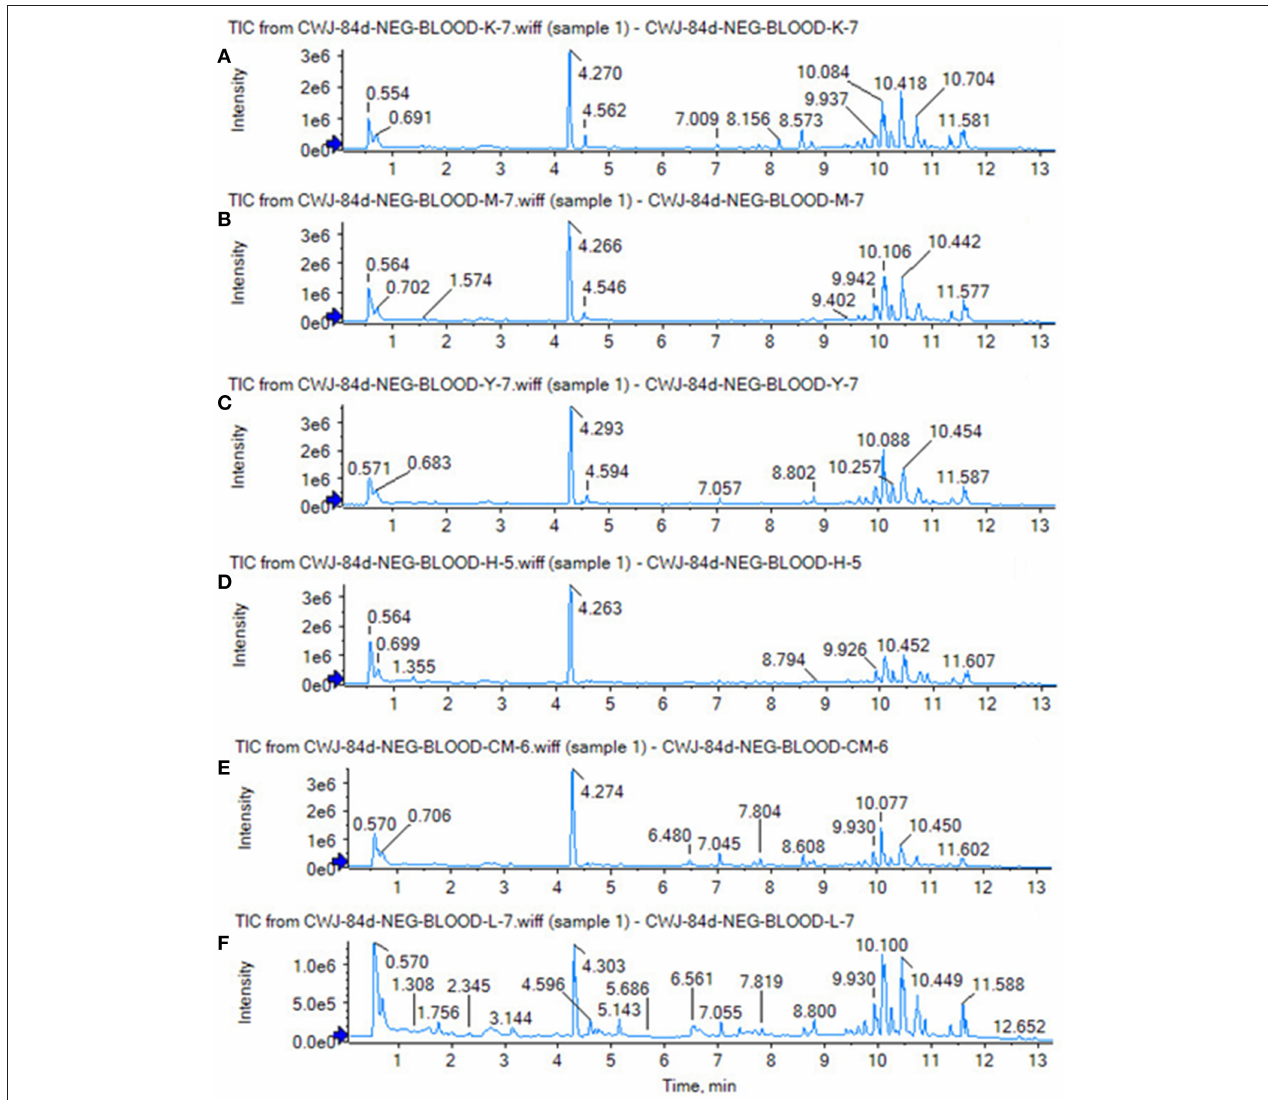
FIGURE 10 | TIC of total lignans on the ovariectomized osteoporosis rat model in negative ion mode. (A) Sham operation group; (B) OVX Model group; (C) NYL; (D) ASSLH; (E) ASSLM; (F) ASSLL.